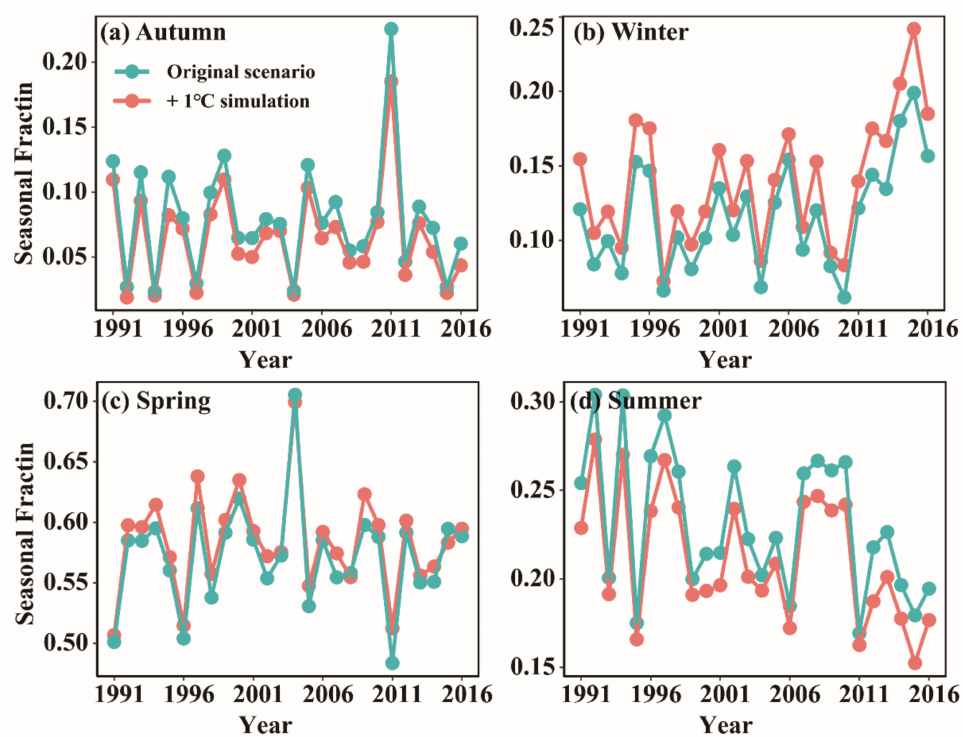
Figure 8. Differences in the fraction of seasonal streamflow out of the total annual streamflow between simulation under 1 ◦ C warming scenario (daily minimum and maximum temperature increased by 1 ◦ C relative to the reference simulation) and that under the reference simulation in the Cleve Creek watershed during 1990 to